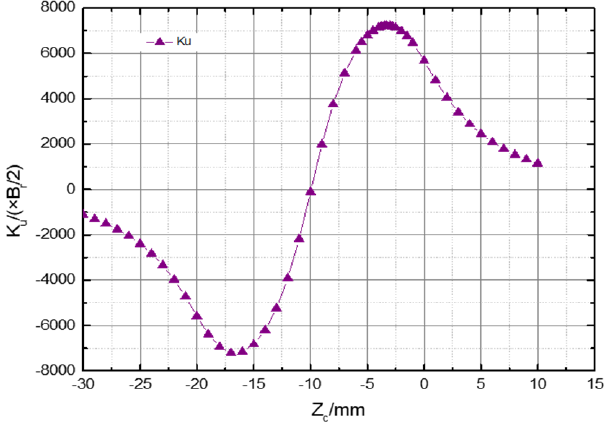
Figure 13. Variation of electromechanical coupling coefficient with z c . If a group of generator arrays is placed at the position of each node, the electromotive force at each coil of the bridge distributed damping and energy acquisition system can be calculated according to the maximum electromechanical coupling coefficient and the velocity time series of each point obtained by a finite element simulation, as shown in Figure 14.